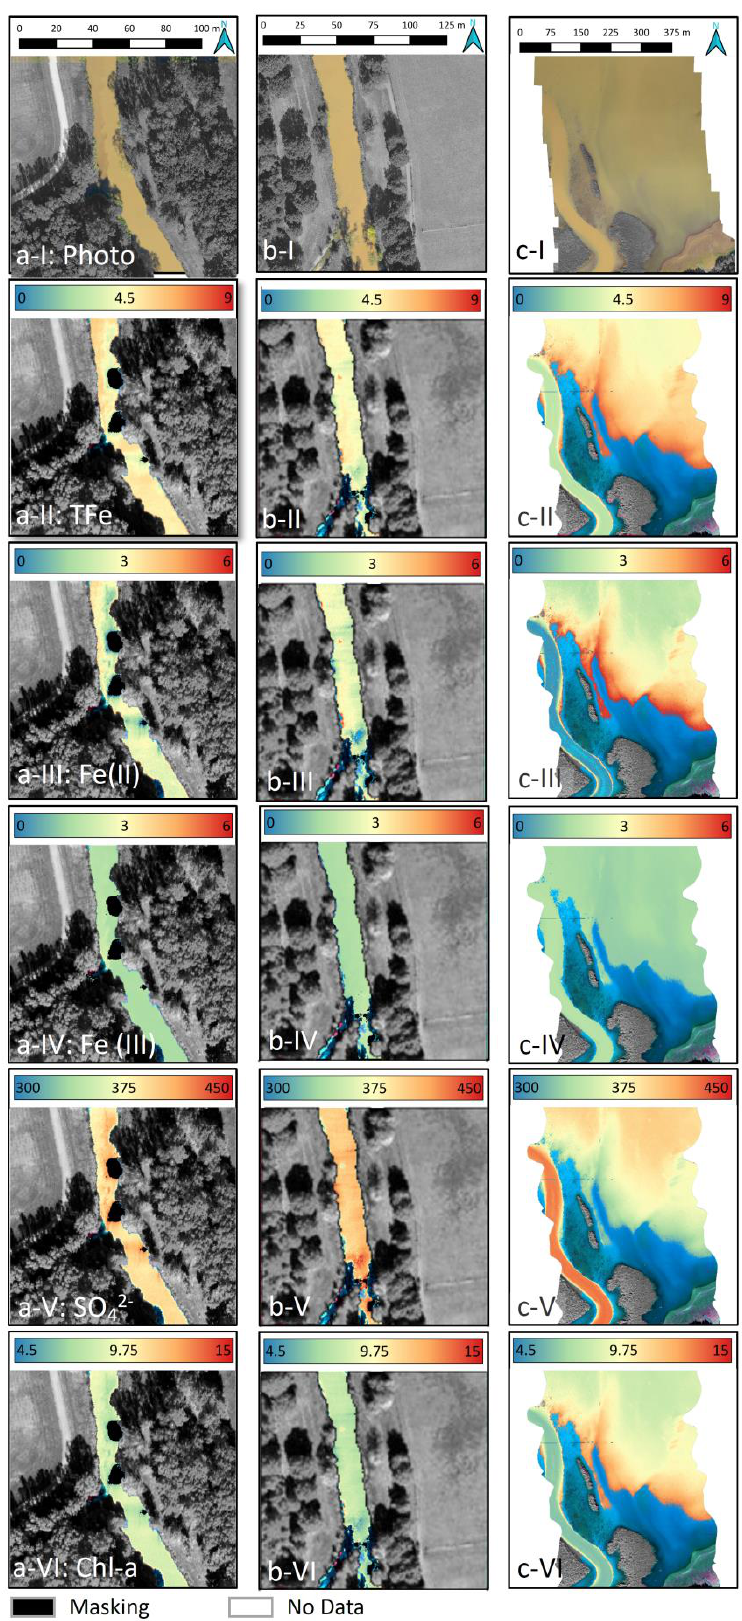
Figure 8. Three different regions with the corresponding derivation results of ( II ) TFe [mg/L], ( III ) Fe(II) [mg/L], ( IV ) Fe(III) [mg/L], ( V ) sulphate [mg/L] and ( VI ) Chl-a [ µ g/L] are shown in columns: ( a ) the estuary of the Kleine Spree River, ( b ) an industrial canal, and ( c ) the estuary of the Spree